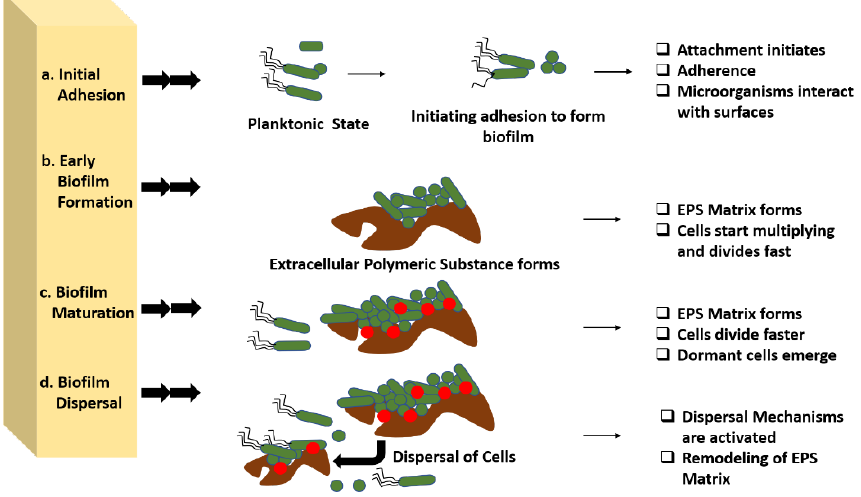
Figure 2. Developmental stages of biofilm and various opportunities for antibiotic interventions in these stages. Four distinct stages are present in biofilm development that can be used for various therapeutic interventions. ( a ) Initial adhesion: in this stage therapeutic intervention can be performed by completely disrupting the adherence mechanism of the microbes with the surface by targeting the cell surface-associated enzymes called adhesins. ( b ) In early biofilm formation, the biofilm can be targeted in the production of extracellular polymeric substances along with the cellular division